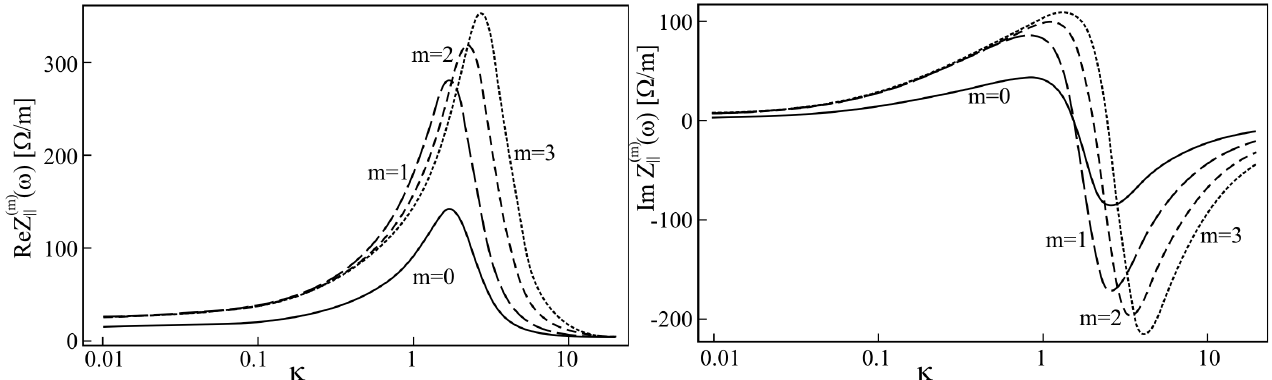
FIG. 2. The real (left) and imaginary (right) parts of longitudinal modes ( m (cid:2) 0 ; 1 ; 2 ; 3 ) for stainless steel–copper tube. Copper layer thickness (cid:1) (cid:2) 100 nm